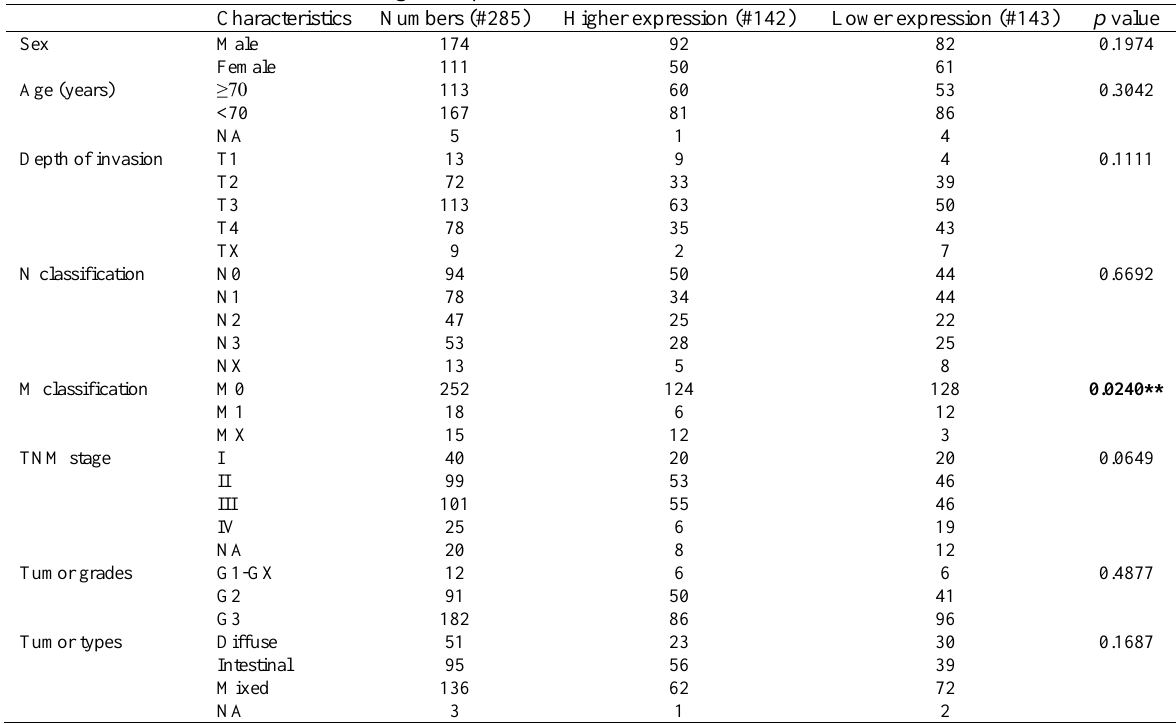
Table 3. Correlation between HNF1A-AS1 expression and clinicopathological parameters of gastric cancer patients of the TCGA cohort based on median gene expression level.